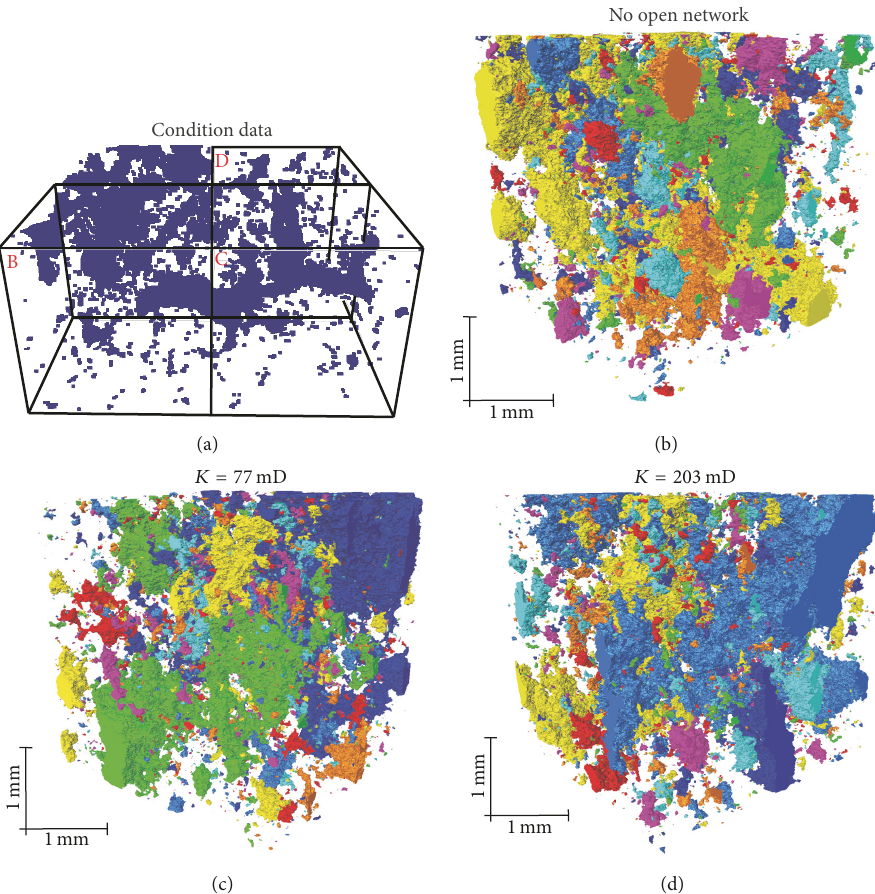
Figure 17: Computer-generated models of a subhorizontal facies sample with 𝜎 = 0.25. (a) Conditioning data, with three different subvolumes “B,” “C,” and “D” indicated. (b) Simulated rock model based on the conditioning data in subvolume “B”; (c) simulated rock model based on the conditioning data in subvolume “C”; and (d) simulated rock model based on the conditioning data in subvolume “D.” The same TI is used in each simulation. Similar colors indicate pores that are